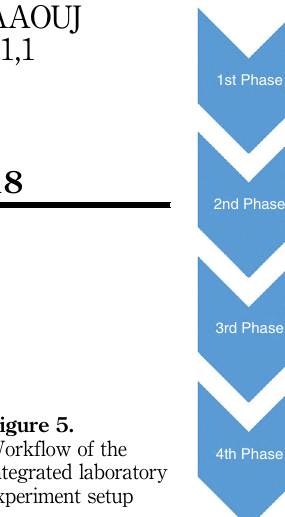
Figure 5. Workflow of the integrated laboratory experiment setup